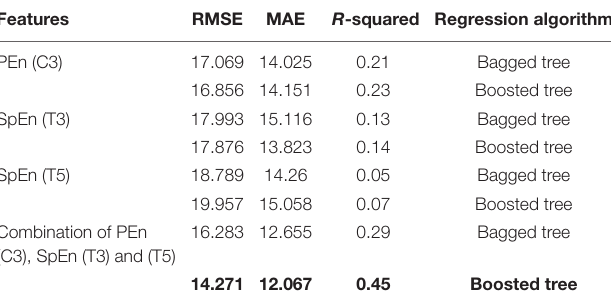
TABLE 6 | Performance of the tree ensemble regression models using the significant entropies features computed from IMF9 (0.5–1.5 Hz).